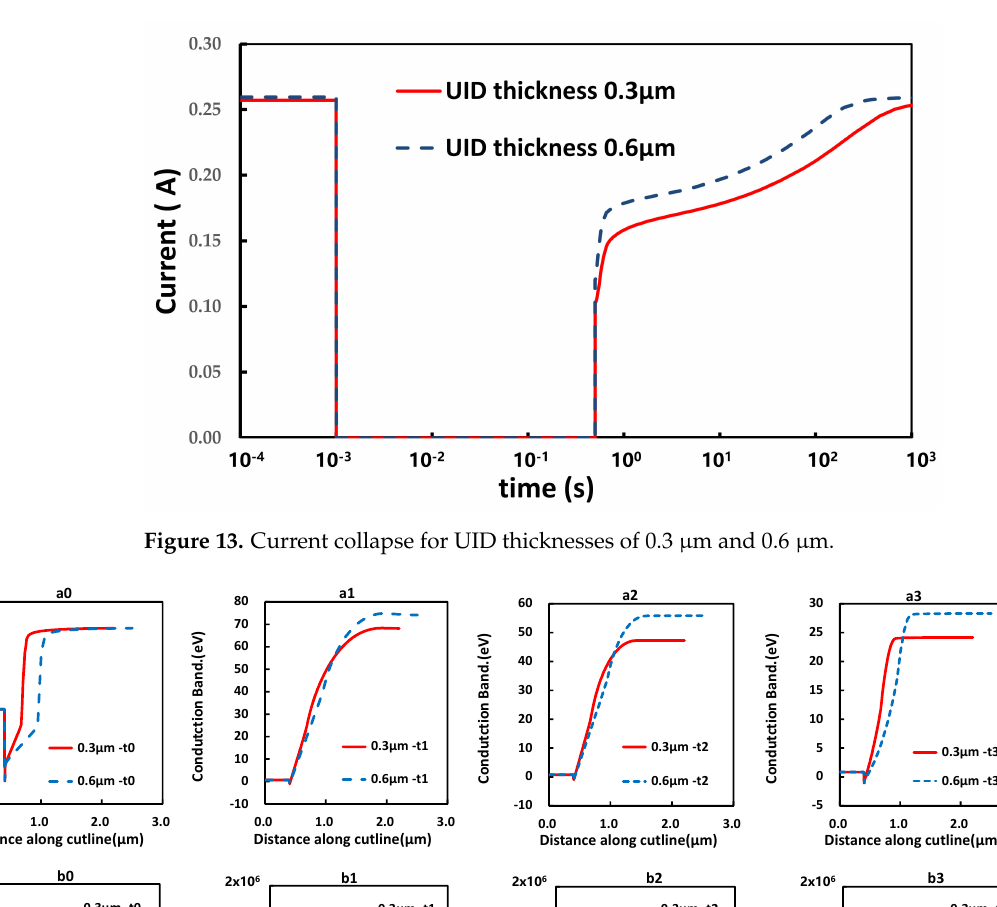
Figure 14. ( a 0 – a 3 ) The conduction band of the device with different UID GaN channels at moments t 0 ~t 3 . ( b 0 – b 3 ) The electric field of the device with different UID GaN channels at moments t 0 ~ t 3